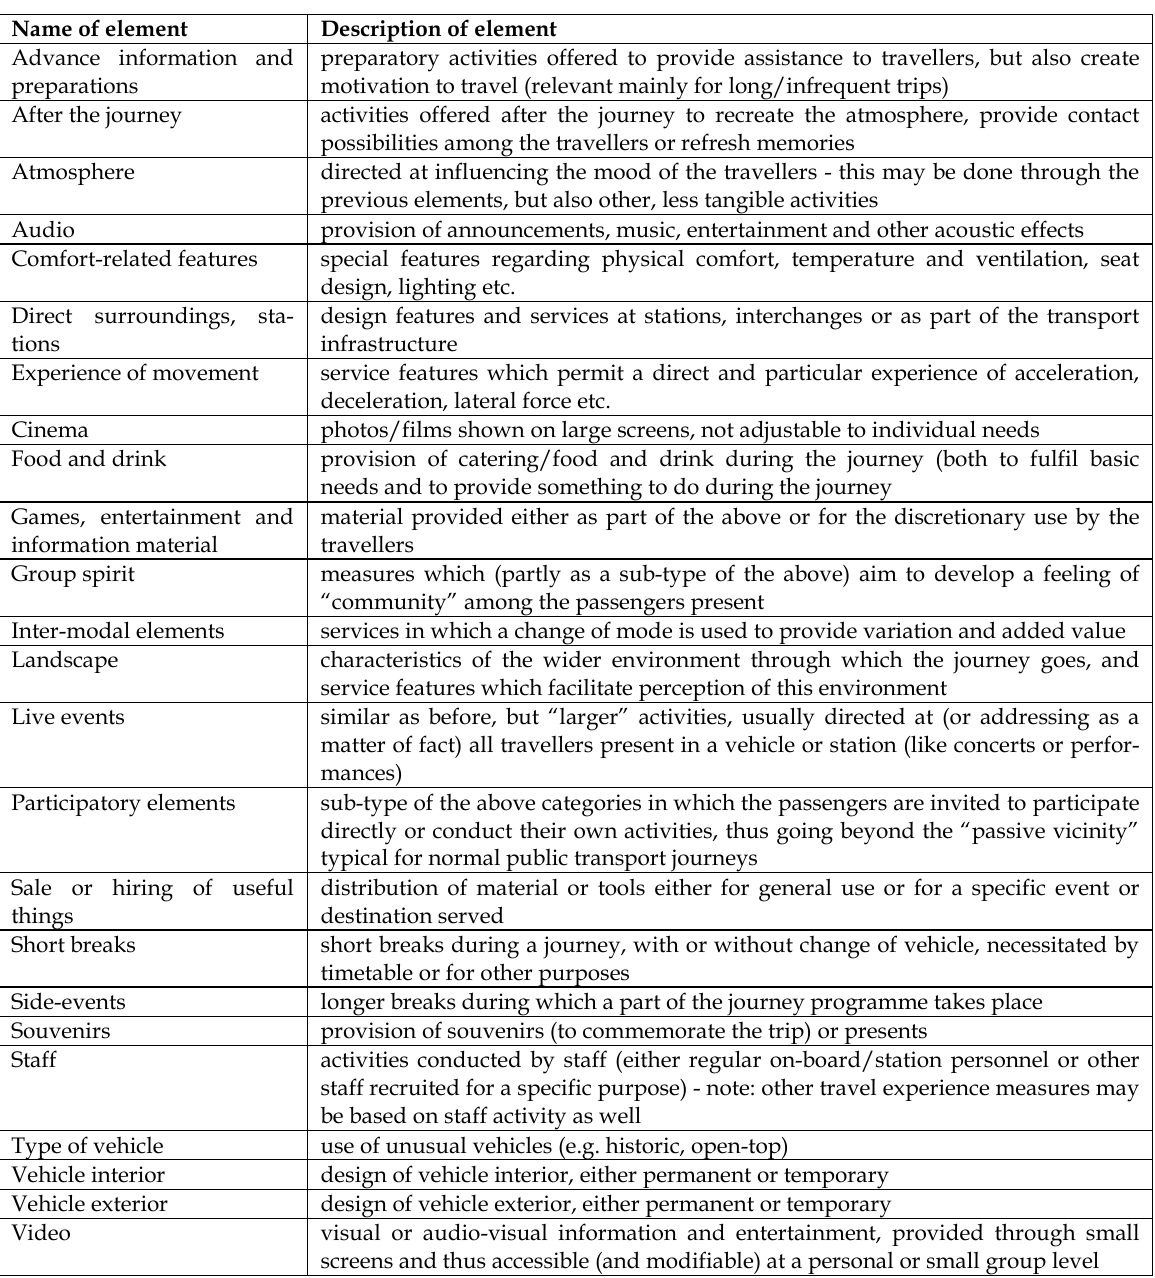
Table 1. Brief definition of the experience elements (author’s